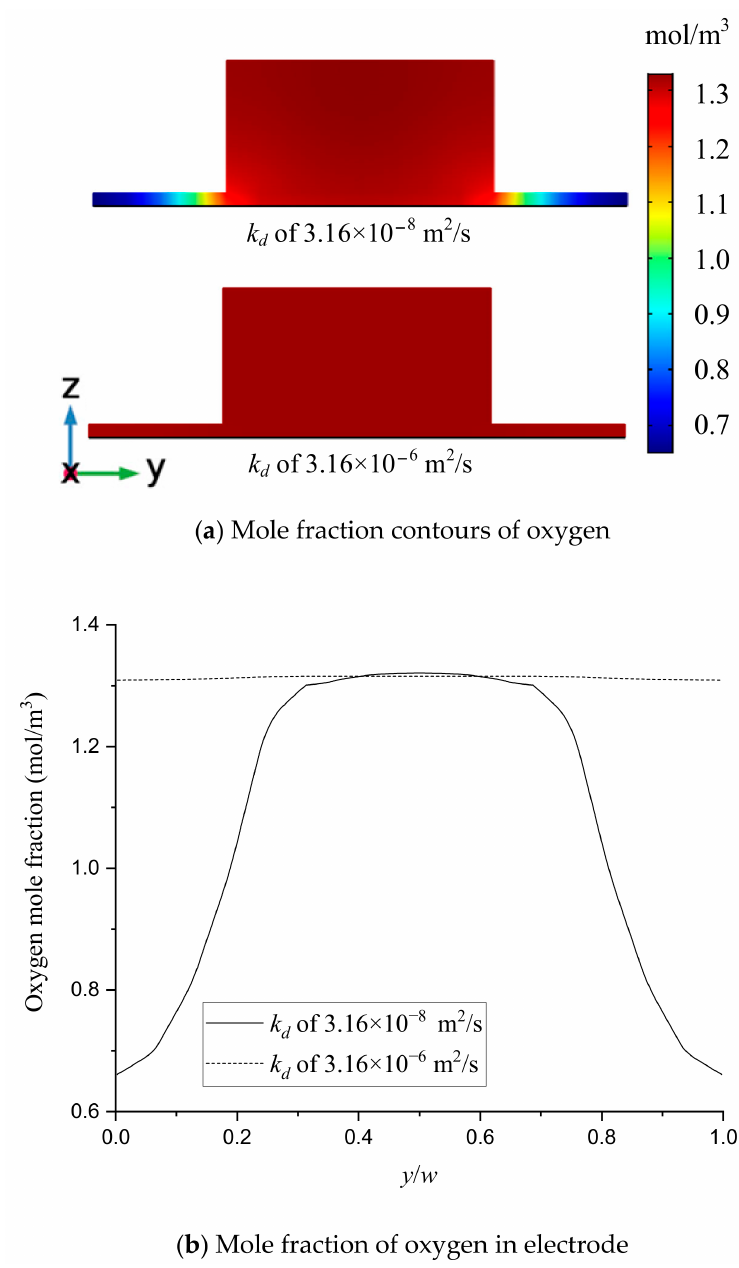
Figure 8. Distribution of oxygen mole fraction on the middle cross section: ( a ) mole fraction contours of oxygen and ( b ) mole fraction of oxygen in